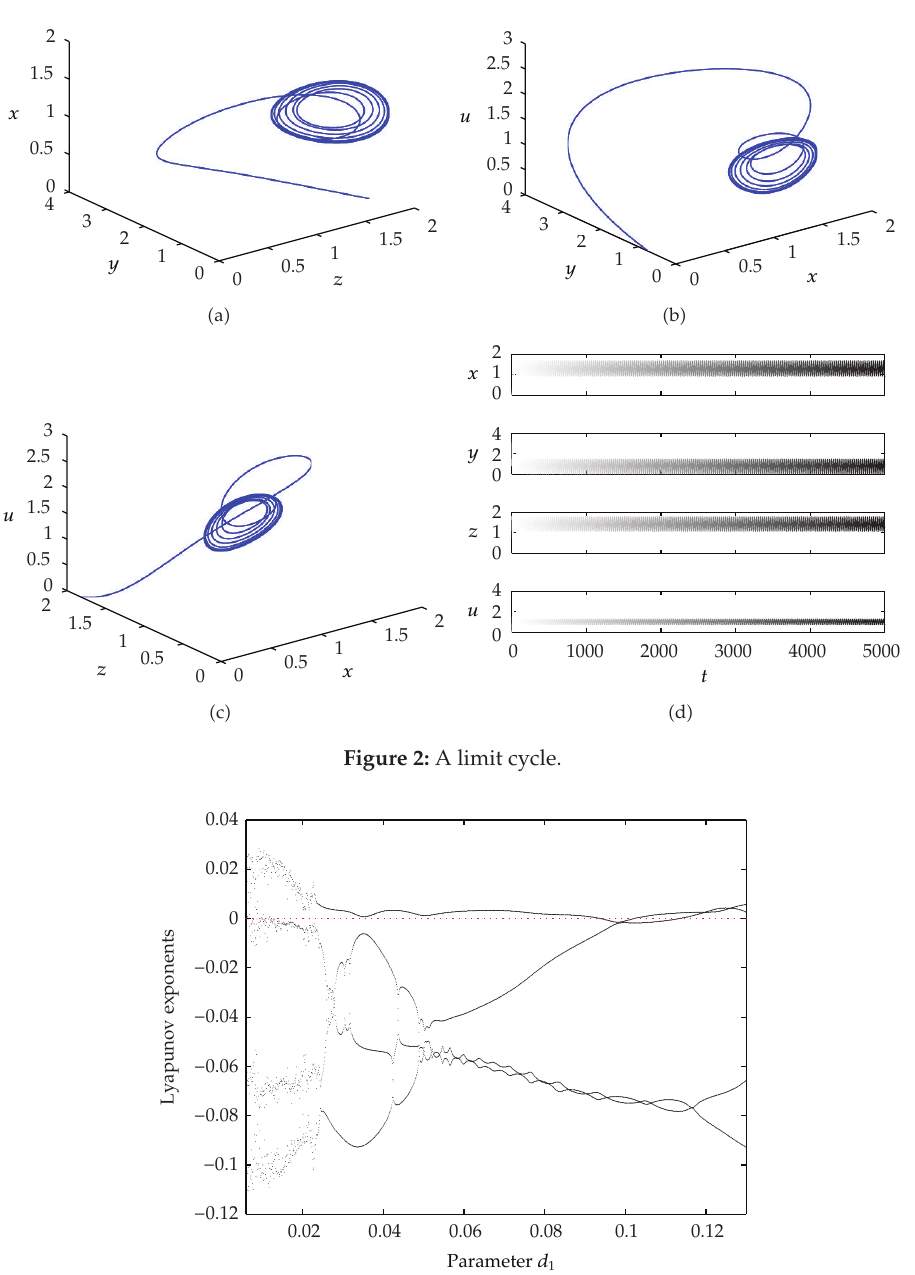
Figure 3: Lyapunov exponent